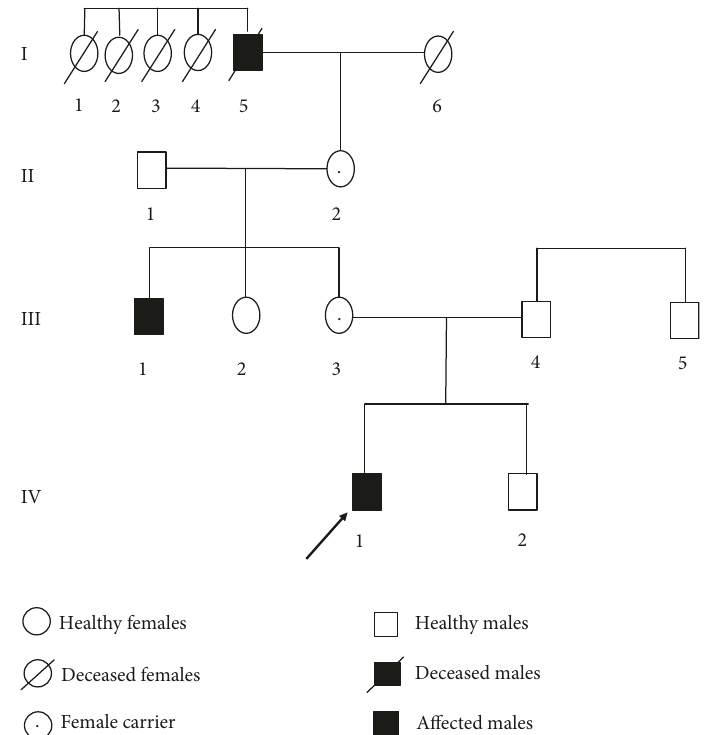
Figure 1: This is the pedigree of a Chinese SEDT family. I, II, III, and IV indicate the fi rst to fourth generations of the families, and the arrow indicates the proband (IV1). All open boxes represent healthy males, and open circles represent healthy females. Filled boxes represent a ff ected males. Boxes or circles with a crossed line indicate that the person has already died. All circles with a dot in the middle indicate the status of the